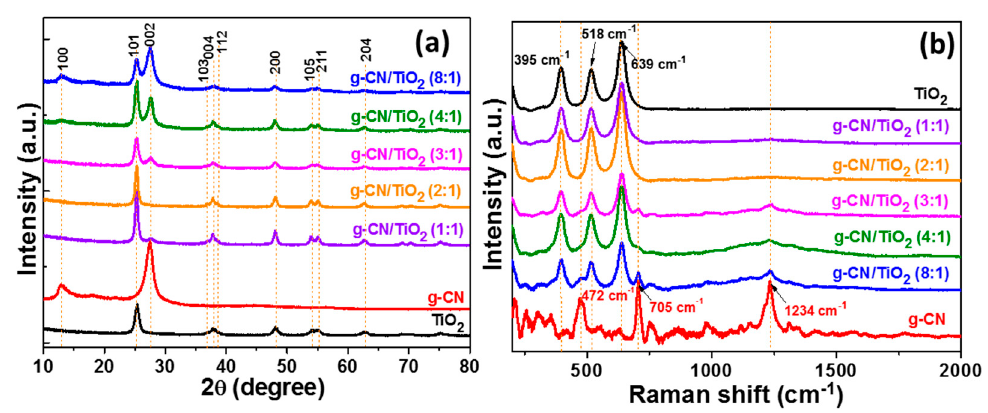
Figure 4. ( a ) X-ray powder diffraction (XRD) patterns and ( b ) Raman spectra of TiO 2 , g-CN, and g- CN/TiO 2 composites.